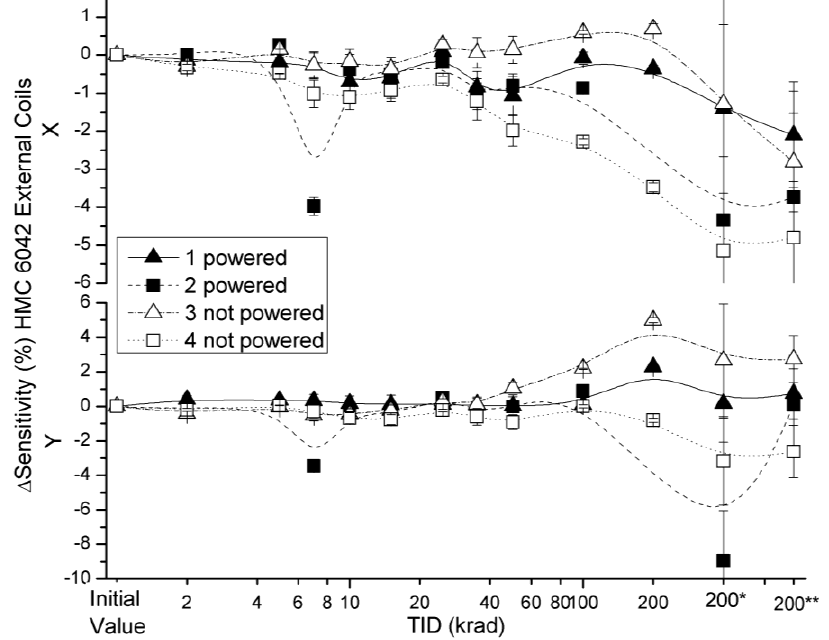
Figure 9. Sensitivity deviation measured for external coil configuration, as a function of TID for powered and non-powered HMC